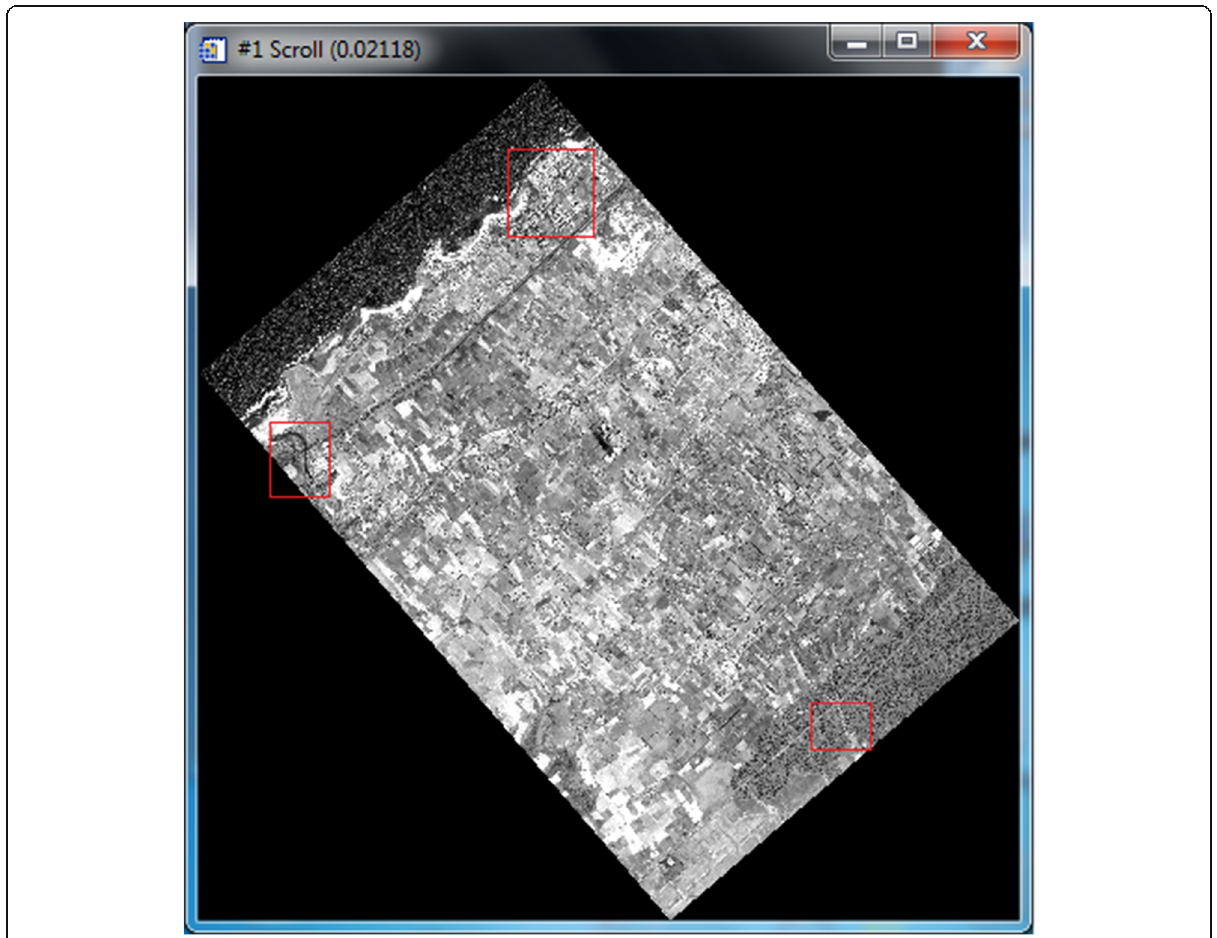
Fig. 2 ®Digital Globe: area of study — QuickBird panchromatic image — region of interest for panchromatic image (urban areas, forest, and